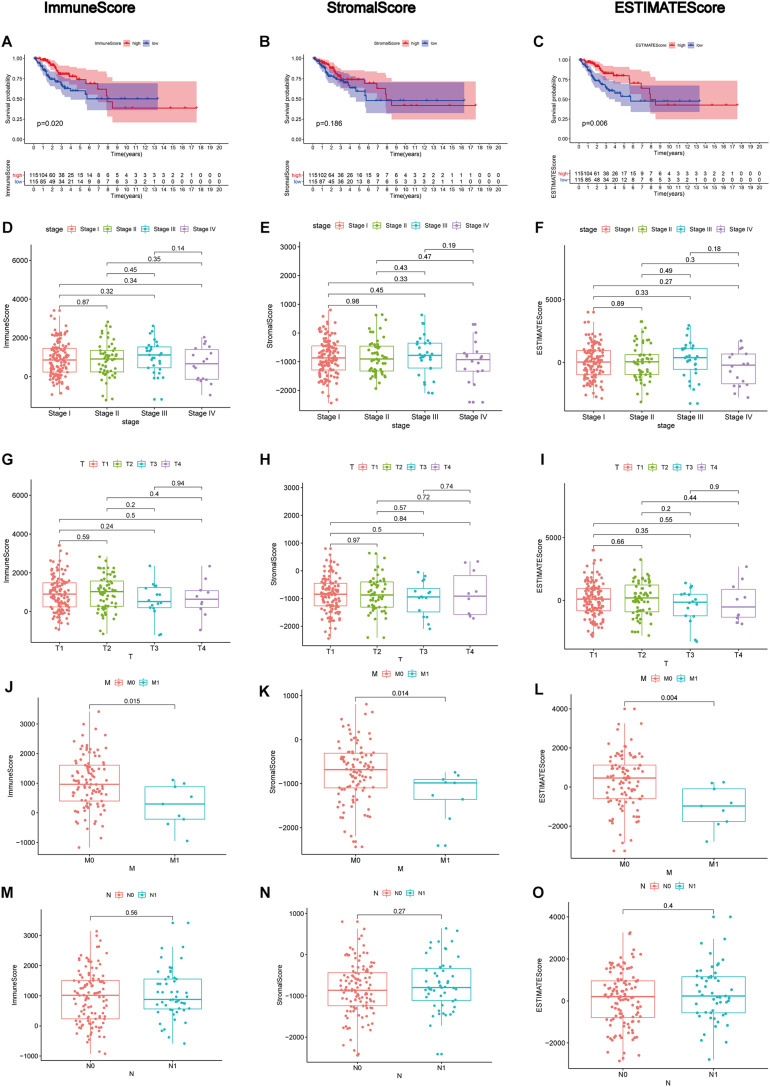
Correlation analyses of scores with survival and clinicopathological characteristics of CC patients. (A–C) Kaplan–Meier survival analysis for CC patients grouped into high or low scores in ImmuneScore, StromalScore, and ESTIMATEScore determined by comparing them with the median. p = 0.020, 0.186, and 0.006, respectively, by log-rank test. (D–F) Distribution of ImmuneScore, StromalScore, and ESTIMATEScore in the stage classification. The p = 0.45, 0.43, and 0.49, respectively, by Kruskal–Wallis rank sum test. (G–I) Distribution of three kinds of scores in the T classification (p = 0.5, 0.84, 0.55 by Kruskal–Wallis rank sum test for ImmuneScore, StromalScore, and ESTIMATEScore, respectively). (J–L) Distribution of scores in the M classification (p = 0.015, 0.014, 0.004 by Wilcoxon rank sum test for ImmuneScore, StromalScore, and ESTIMATEScore separately). (M–O) Distribution of scores in N classification. Similar to the preceding, p = 0.56, 0.27, 0.40, respectively, with Wilcoxon rank sum test.